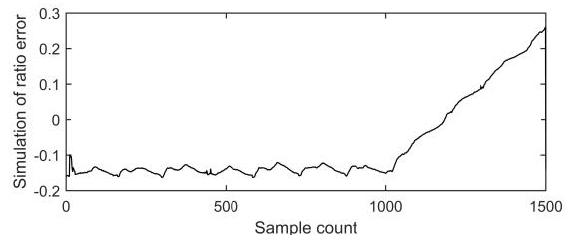
Figure 3. The ratio error of EVT phase-A with simulated fault.